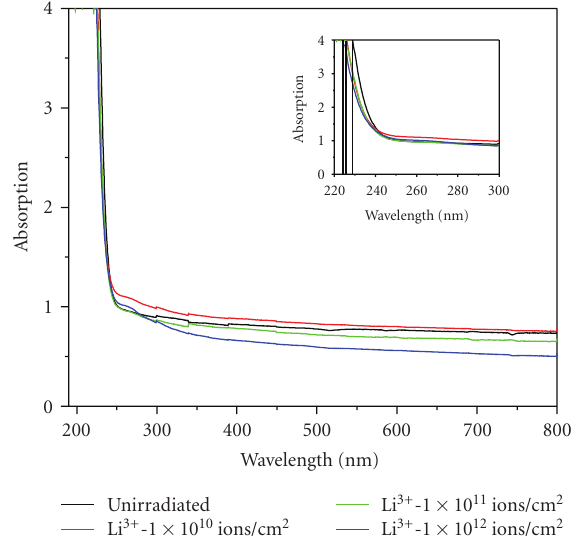
Figure 59: UV-Vis-NIR spectra of unirradiated and irradiated L- threonine single crystals at various ion